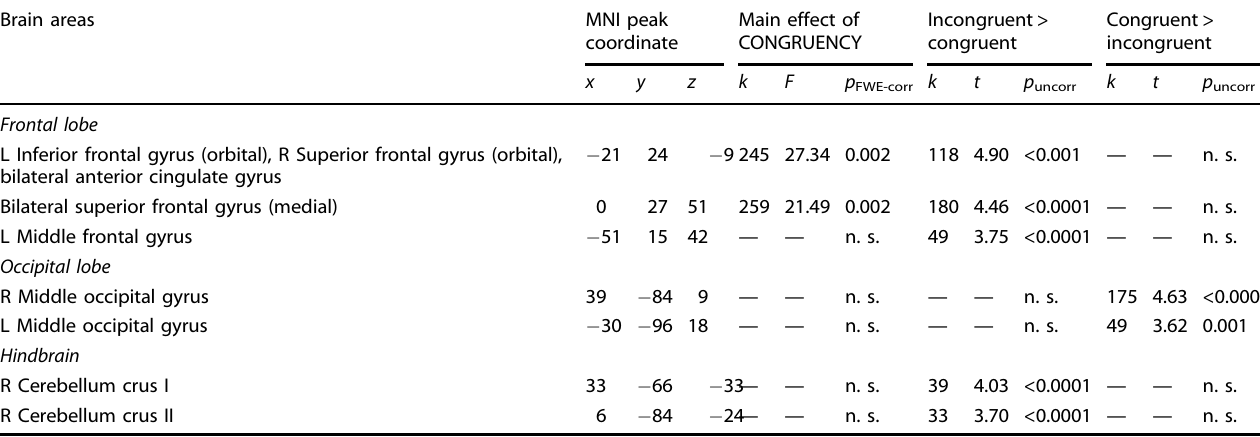
Table 1. Signi fi cant activation clusters for the main effect CONGRUENCY and the subsequent t -contrasts between congruent and incongruent statements.